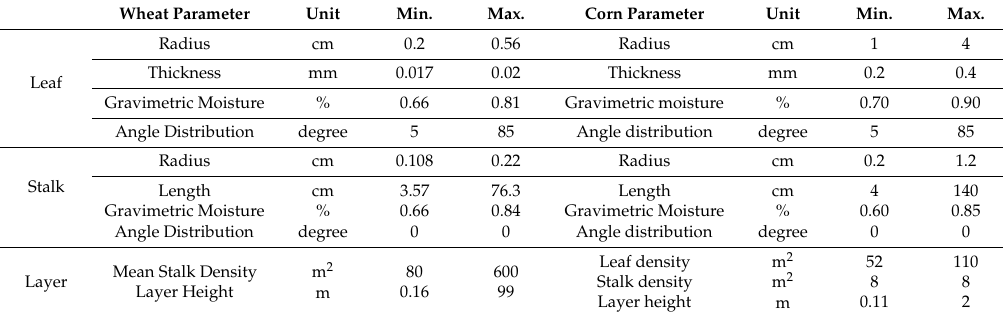
Table 1. Wheat and corn input data for the Tor Vergata model.